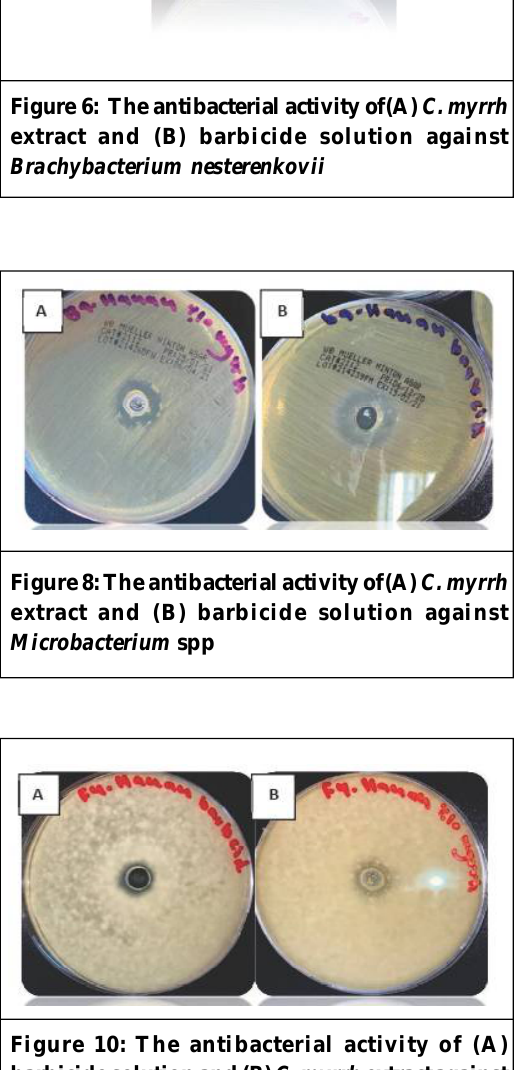
Figure 9: The antibacterial activity of (A) barbicide solution and (B) C. myrrh extract against Penicillium spp